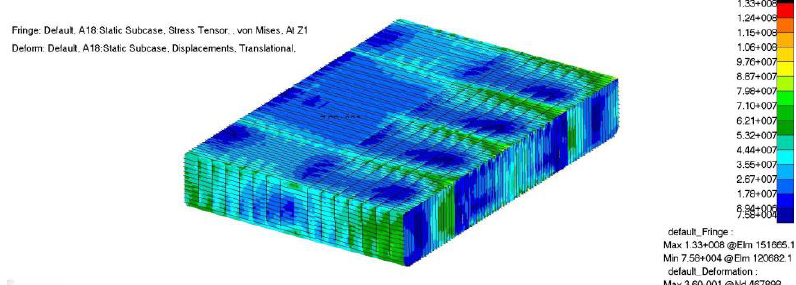
Figure 21. Stress contour plot in decks 4 and 5 when just sitting on the sand.